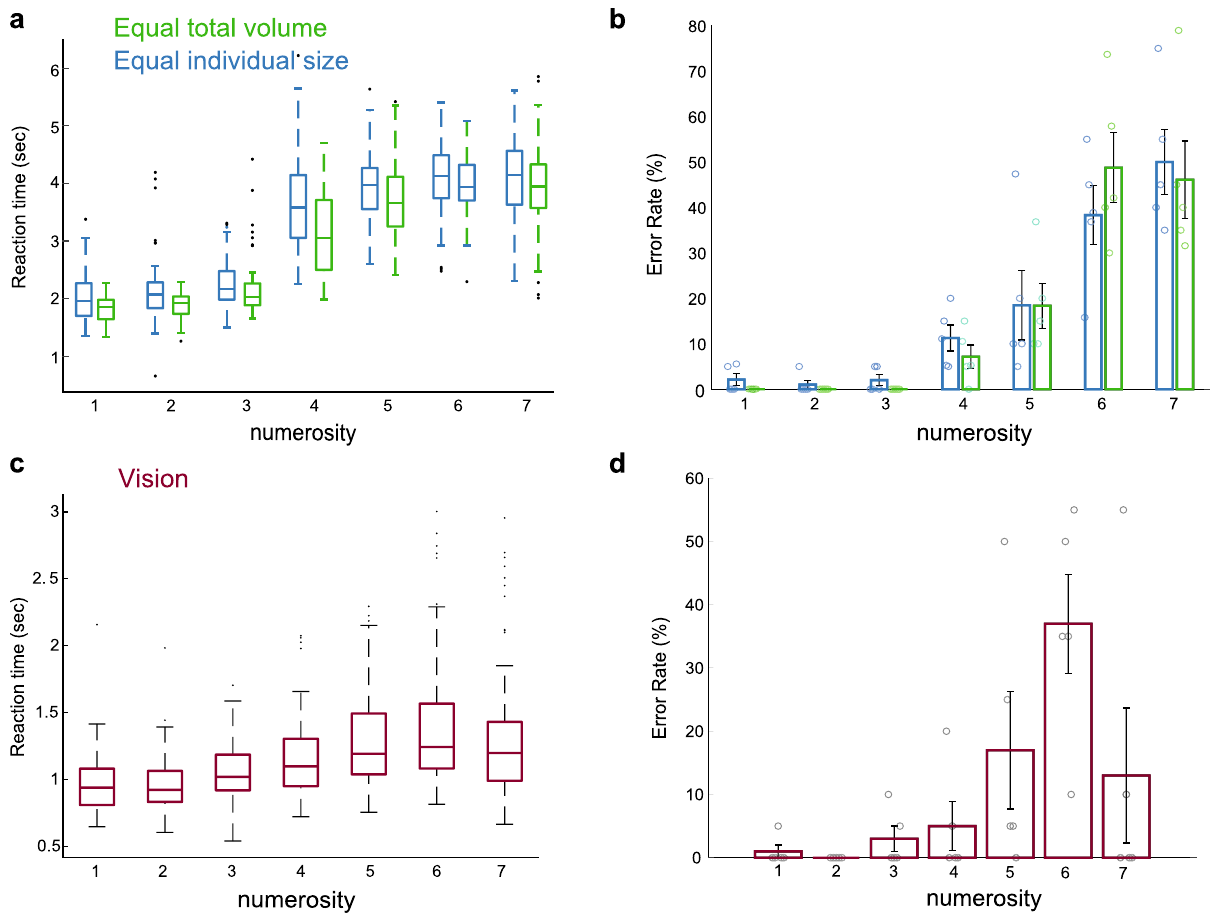
Fig. 6 Numerosity judgment with increased numerosity. a Participants were asked to judge the number of spheres placed in their hands for three seconds. A box-plot diagram shows the distribution of reaction times of all participants for each numerosity ( n = 100 for each numerosity). A similar pattern of increase in reaction time is found for each stimulus condition of the equal total volume of spheres and equal size of individual spheres. b Bar plot presents the percentage of errors in judgment of numerosity averaged across participants (represented by individual dots) and for each haptic stimulus condition. Error bars show the standard error of the mean. Numerosities above the subitizing range are more prone to error. c A box-plot diagram shows the distribution of reaction times of all participants for numerosities that were visually displayed for 300 ms ( n = 100 for each numerosity). A signi fi cant increase in reaction time was found with increased numerosity. d Bar plot shows the percentage of error in judging visual numerosity, averaged across participants (represented by individual dots). Error bars show the standard error of the mean. Above the subitizing range, numerosity judgment is less accurate. Overall, the perception of numerosities in the haptic and visual domains show similar behavior in terms of reaction times and error rates. In the box-plot diagram, the central mark indicates the median, and the bottom and top edges of the box indicate the 25th and 75th percentiles, respectively. The whiskers extend to the most extreme data points not considered outliers, and the outliers are plotted individually using the dot Finally, we also tested whether the pattern of change in reaction time and increase in error rate with numerosity was similar between the visual and haptic experiments. Both reaction times and error rate were well correlated between the visual and haptic domains (Spearman correlation for reaction times: vision and equal total volume of spheres: r s = 0.57 p = 0.00042; vision and equal individual sphere size: r s = 0.61 p = 0.00011; Spearman correlation for error rates: vision and equal total volume of spheres: r s = 0.58 p = 0.00022; vision and equal individual sphere size: r s = 0.49 p = 0.0028).